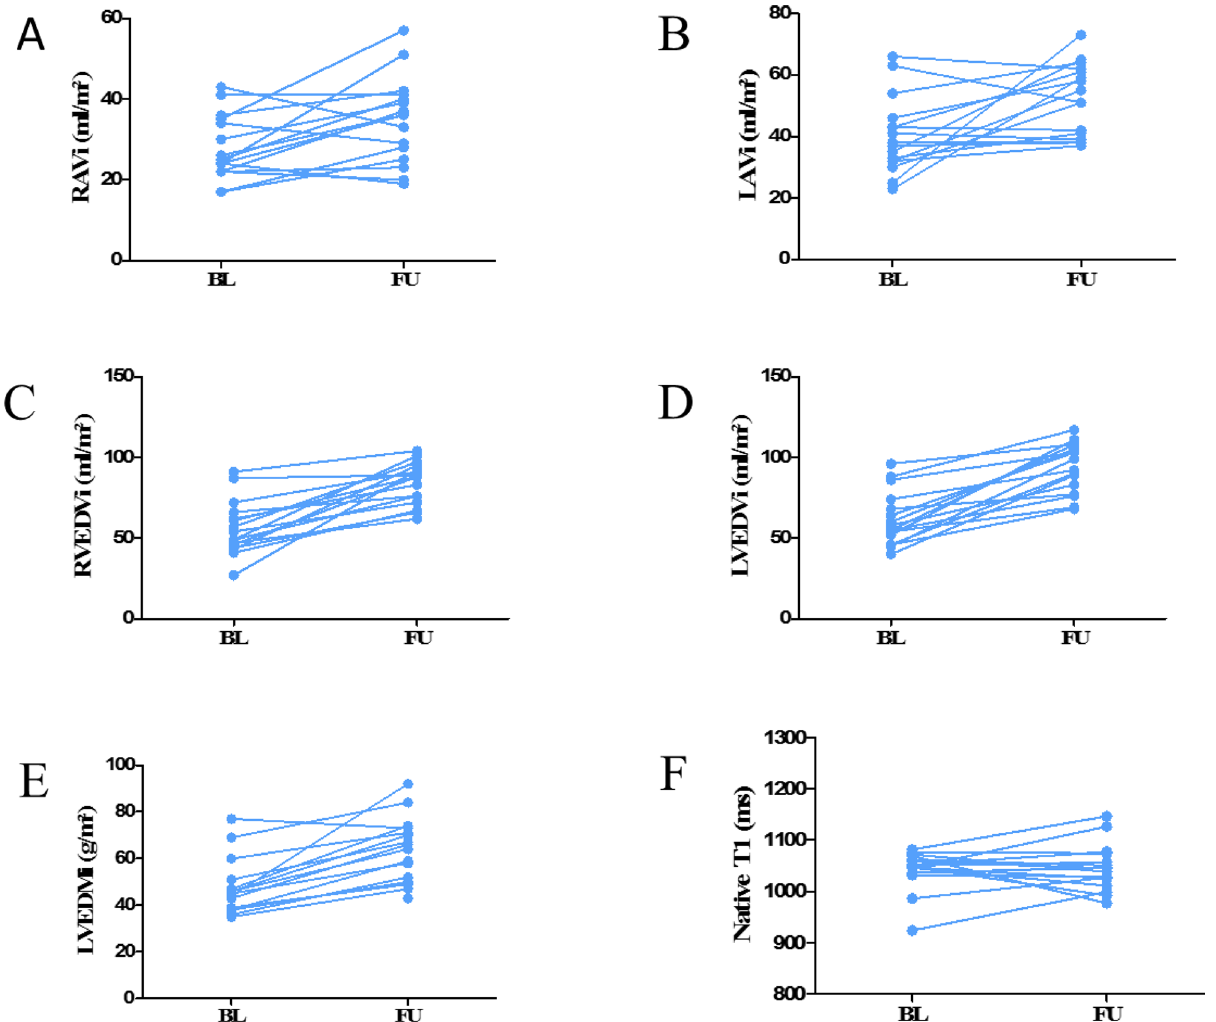
Figure 2. Individual development of RAVi ( A ), LAVi ( B ), RVEDVi ( C ), LVEDVi ( D ), LVEDMi ( E ) and global native T1 ( F ) from BL to FU. Created with: GraphPad Prism 6.00; https:// www. graph pad. com/ scien tific- softw are/ prism/. Abbreviations : LAVi = indexed left atrial volume; LVEDMi = indexed left ventricular end- diastolic mass; LVEDVi = indexed left ventricular end-diastolic volume; RAVi = indexed right atrial volume; RVEDVi = indexed right ventricular end-diastolic